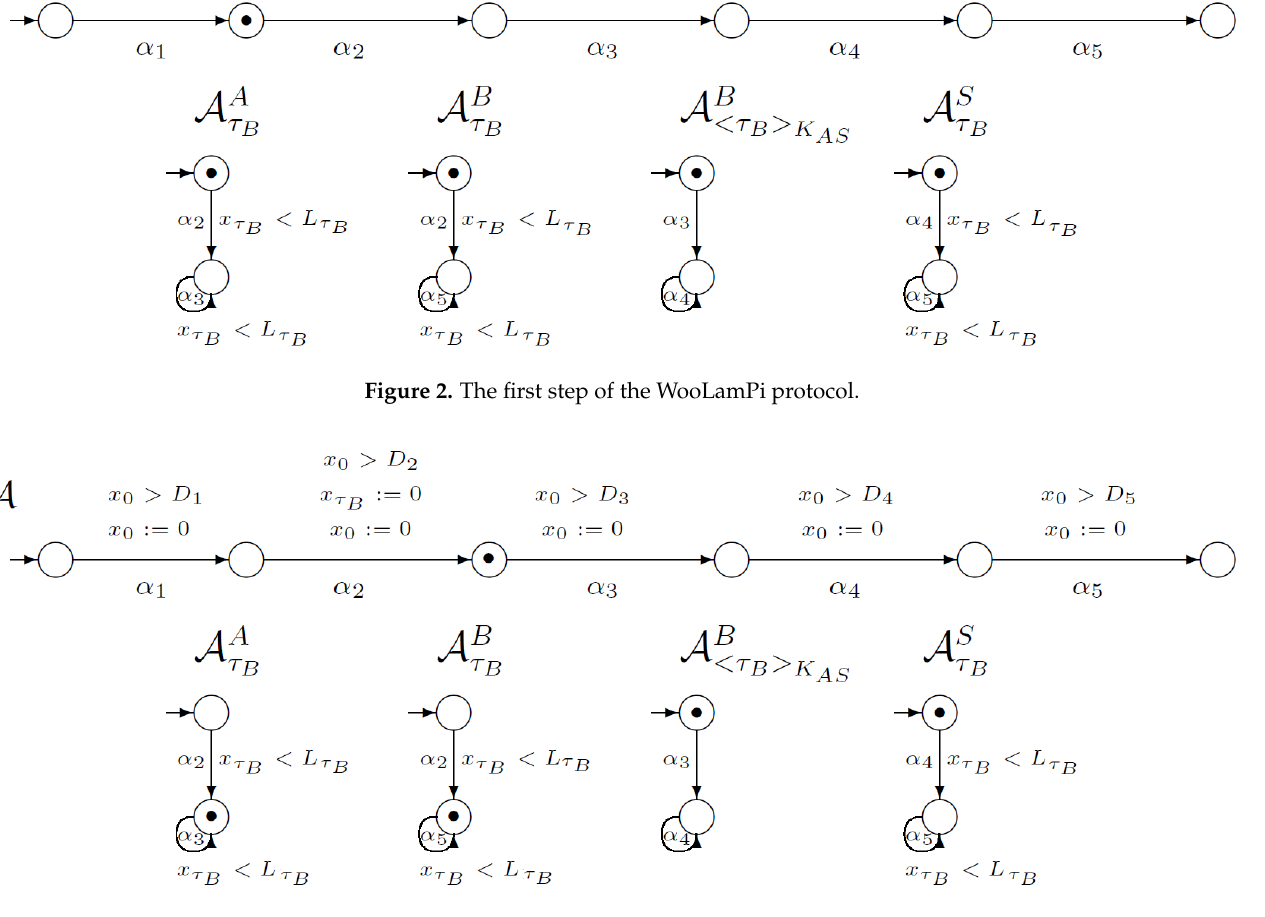
Figure 3. The second step of WooLamPi